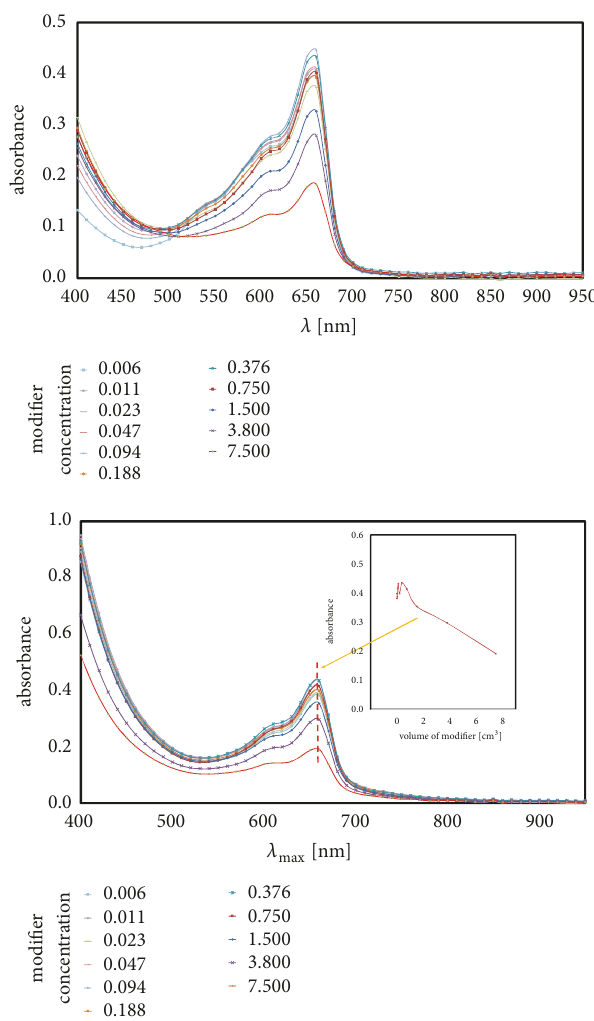
Figure 2: Absorbance band intensity changes in function of eleven concentration values for blind samples (upper) and for eleven concentrations first measurement (bottom).